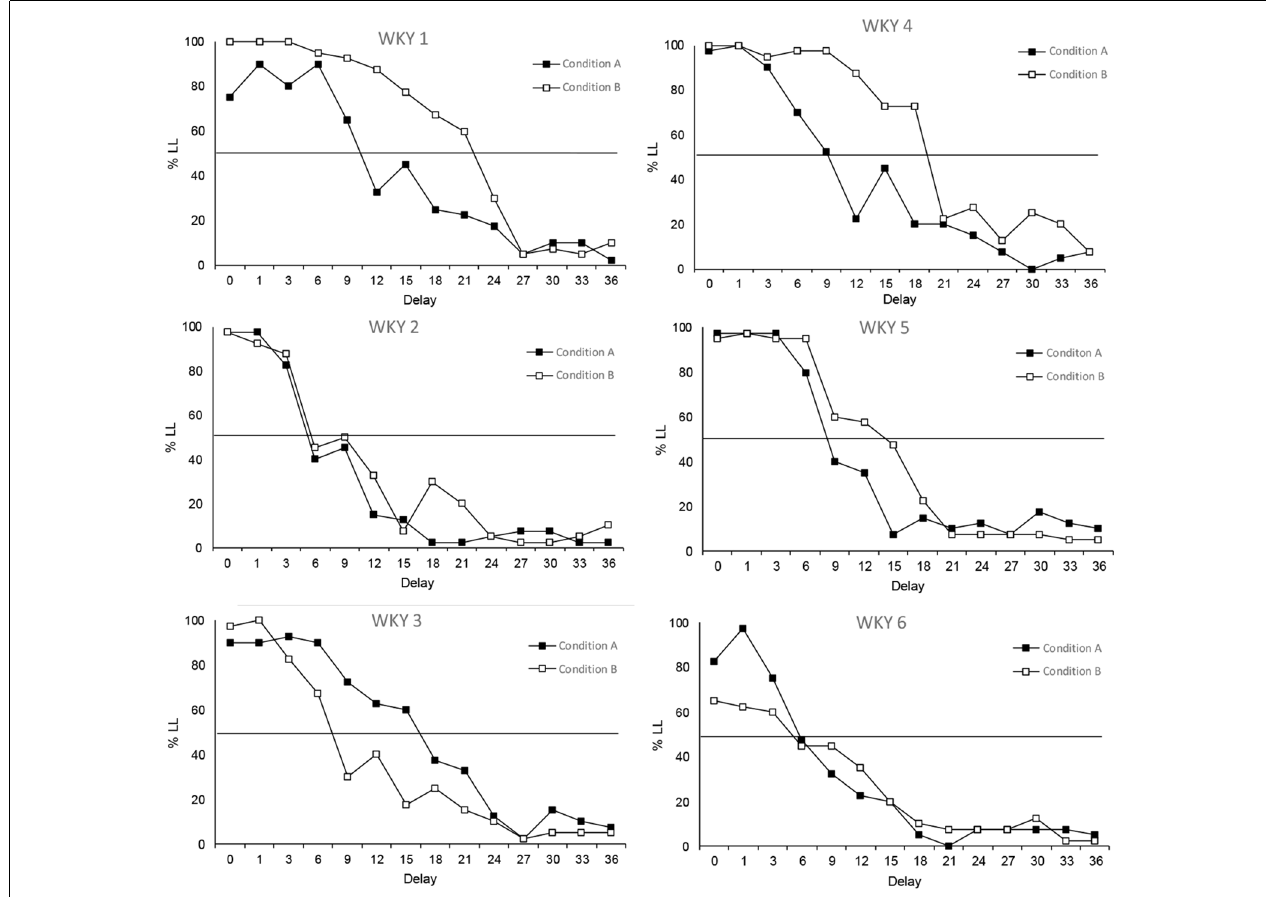
FIGURE 6 | Individual percentage of responses of WKY rats to the LL option in each delay. Black circles depict data from Condition A and white squares from Condition